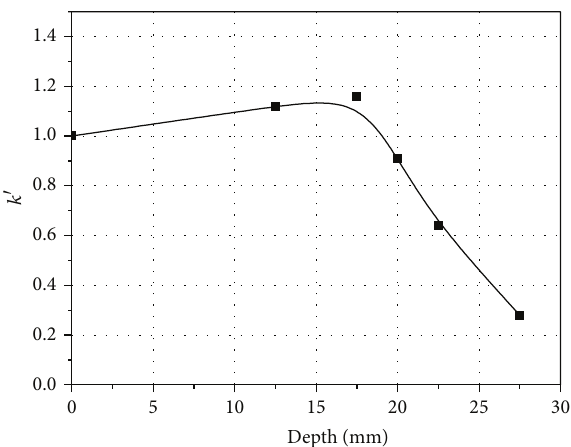
Figure 11: Correlation between the corrosion resistance coefficient of the strength of corroded concrete layer and the corrosion